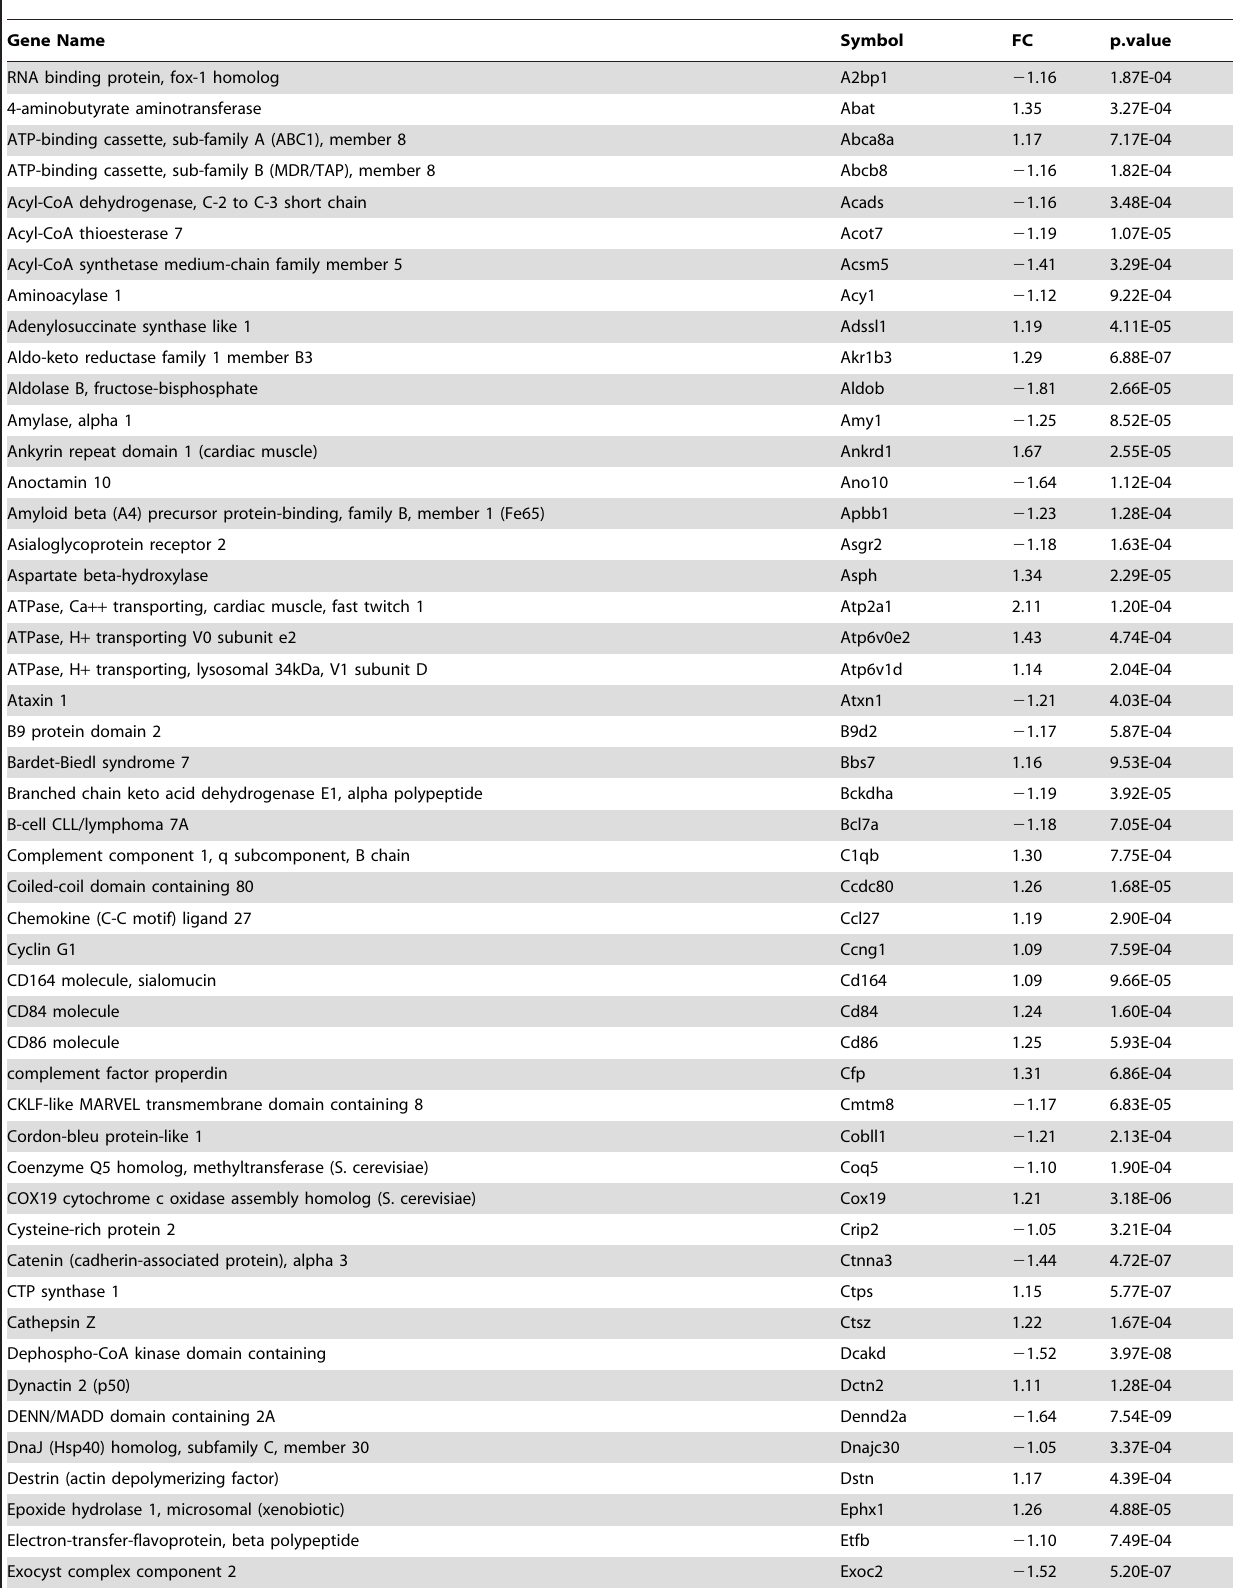
Table 2. List of significant, differentially expressed genes, attributed to genotype (P , 0.05, 2-Way ANOVA) between ER Alpha KO and Wild type